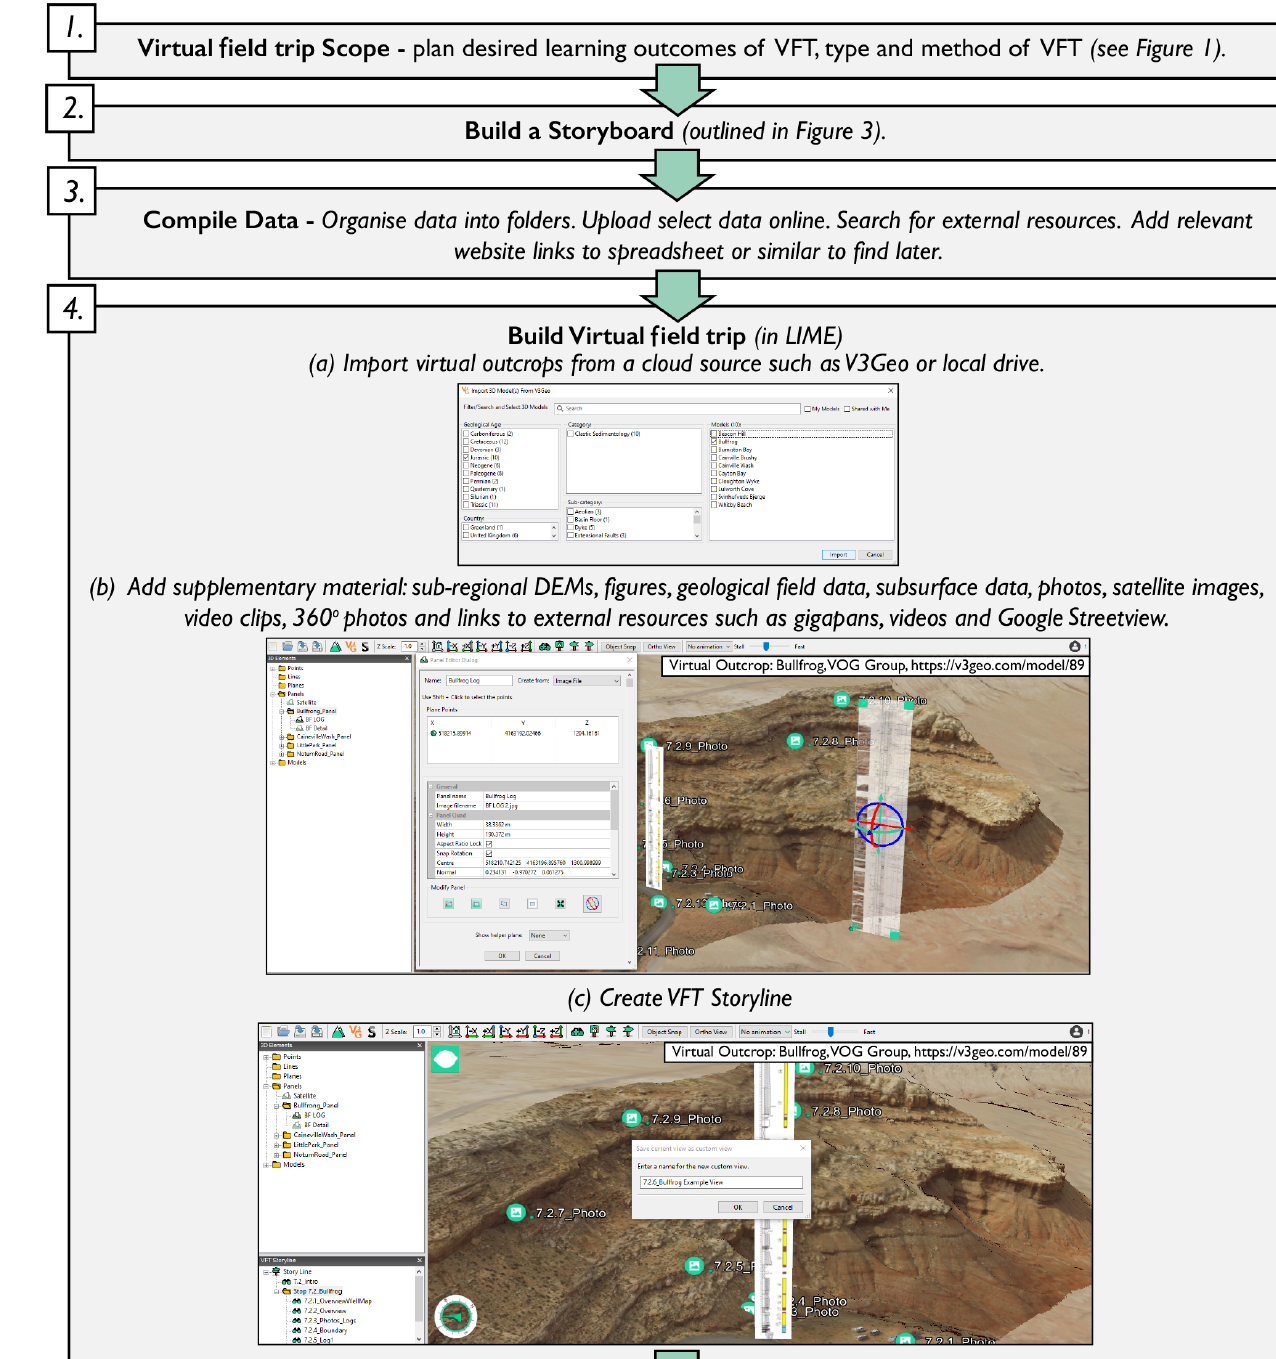
Figure 2. Proposed workflow for building and running VFTs, this workflow was followed for every VFT within this contribution.